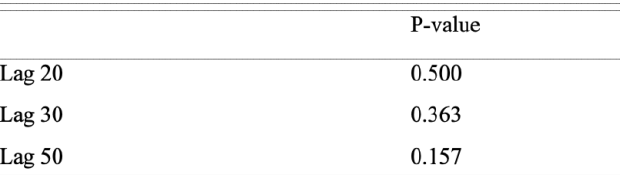
Table 5: Ljung-Box autocorrelation test on the residuals of the model selected by AIC